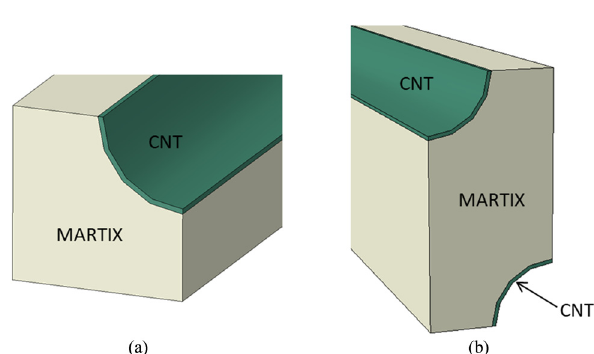
Figure 1: The idealization of CNTs ’ distribution in nanocomposite and representative volume element ( RVE ) for ( a ) square and ( b ) hexagonal distribution.